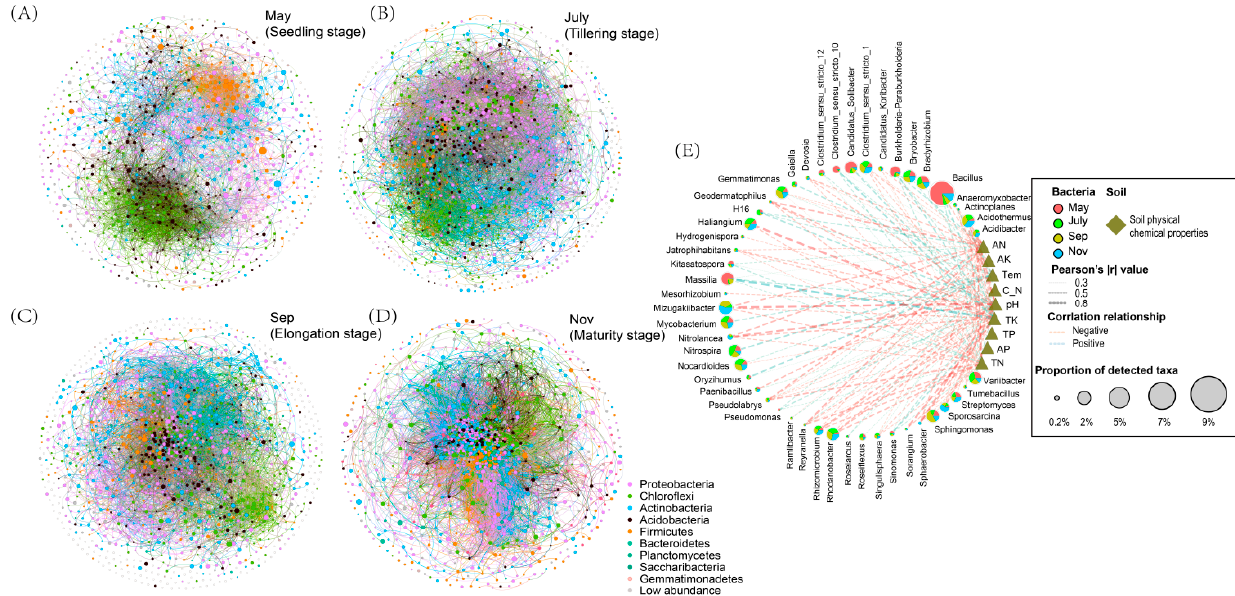
Figure 5. Co-occurrence networks analysis between rhizosphere bacteria OTUs and the different growing seasons of sugarcane. (( A ) May, seedling stage; ( B ) July, tillering stage; ( C ) September, elongation stage and ( D ) November, maturity stage), and the rhizosphere bacteria network have different structural characteristics at four growth stages. ( E ). Co-occurrence network depicting relationship between rhizosphere bacteria and soil physiochemical properties.